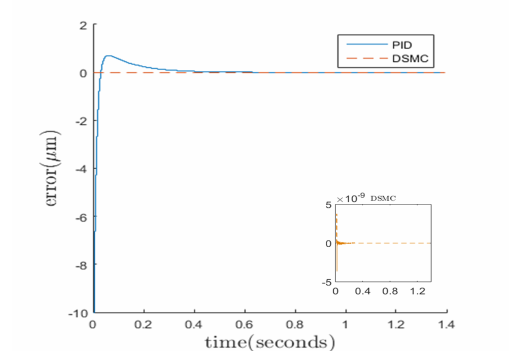
Table 1. Parameters of the plant